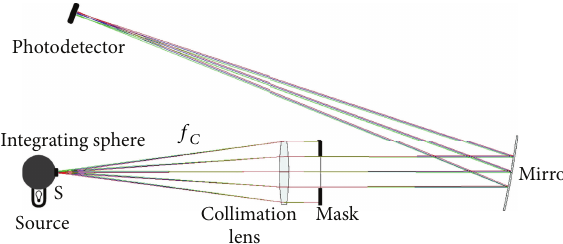
Figure 2: Scheme of collimator S2 (for entering light measurement on small